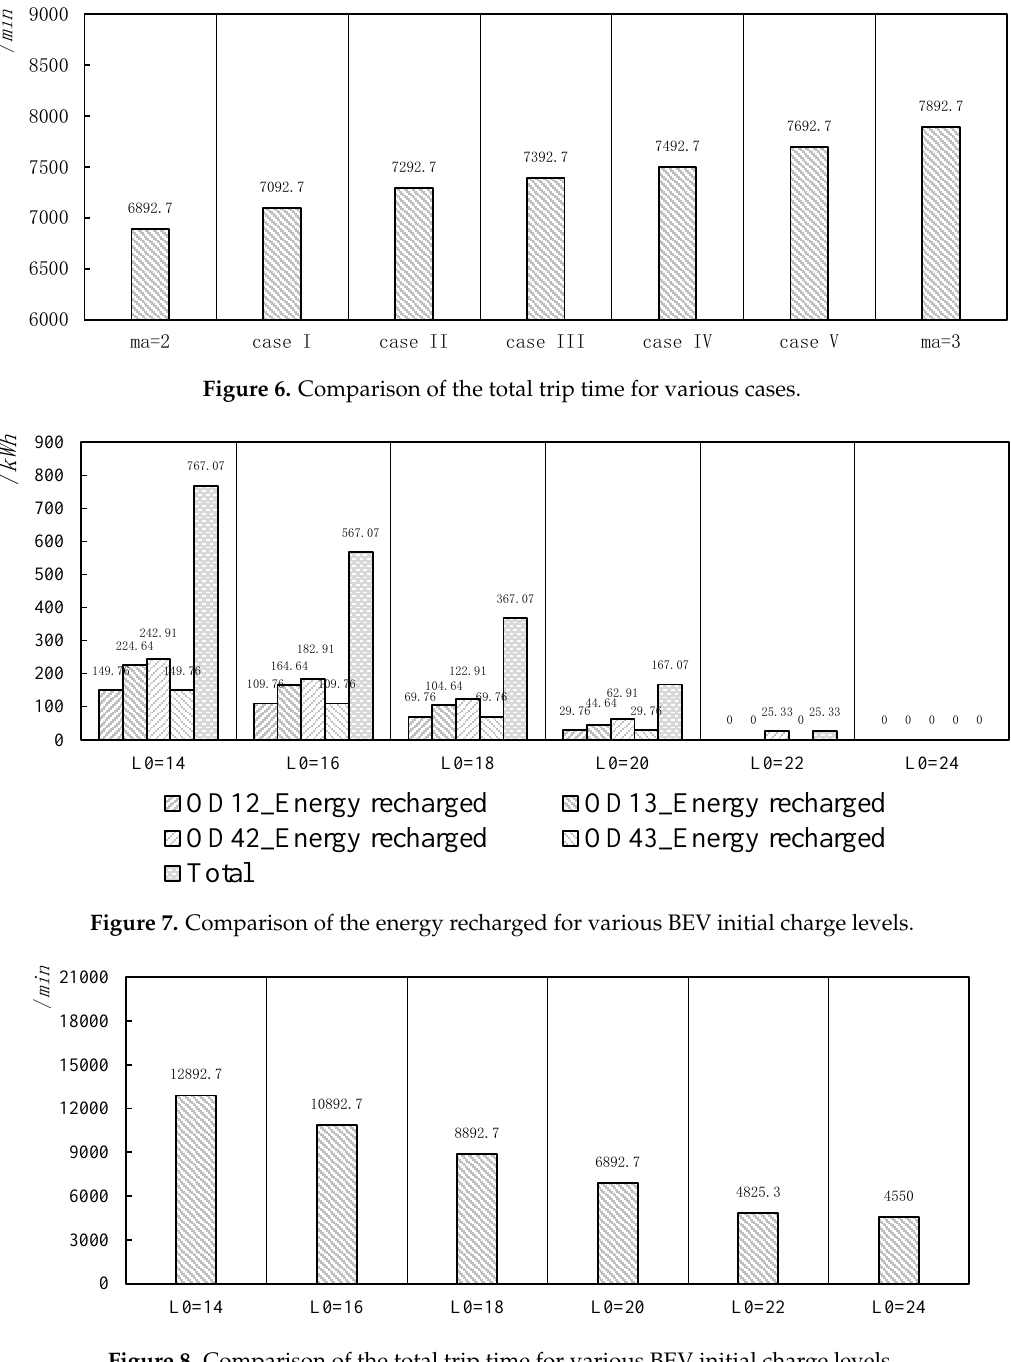
Figure 8. Comparison of the total trip time for various BEV initial charge levels. Table 12. Number of chargers at every node for various initial battery charge levels.